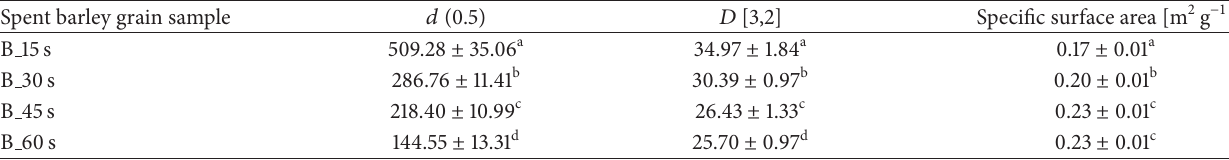
Table 2: Particle size parameters of spent grain used for barley milk production. Results are expressed as mean of 3 measurements ± SD ∗ . Spent barley grain sample 𝑑 (0.5)